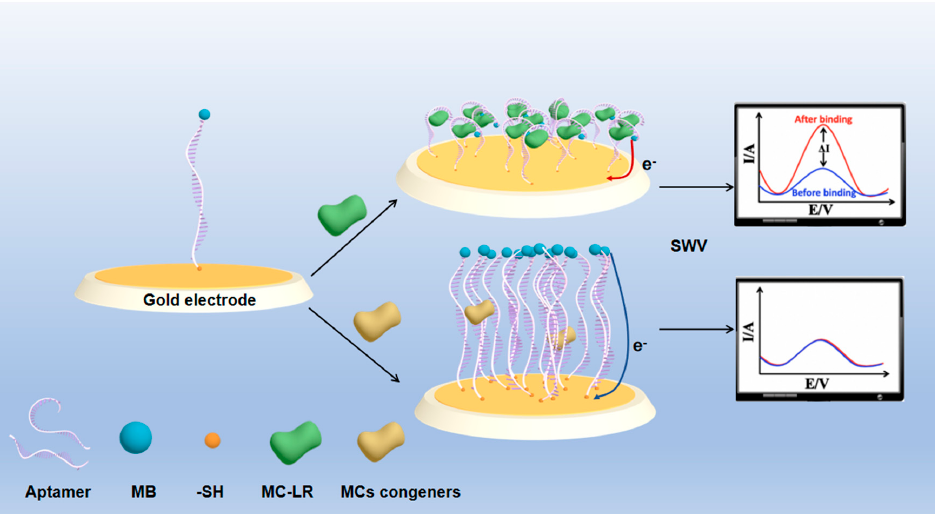
Figure 2. The working principle of the electrochemical sensor for MC − LR detection. In the absence of MC − LR, the methylene blue (MB) − modified aptamer probes are linear. However, in the presence of MC − LR, the probe is presumed to change its conformation, bringing MB closer to the electrode surface, thereby altering the ET kinetics between the MB label and the underlying gold electrode. This alteration in probe conformation and surface diffusivity of the MB label increases the MB current, which is exhibited as a “signal-on” sensor